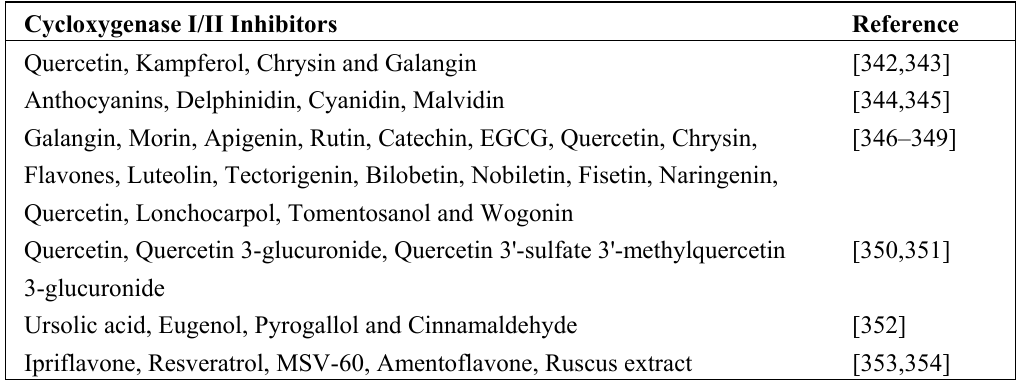
Table 2. Cycloxygenase I/II